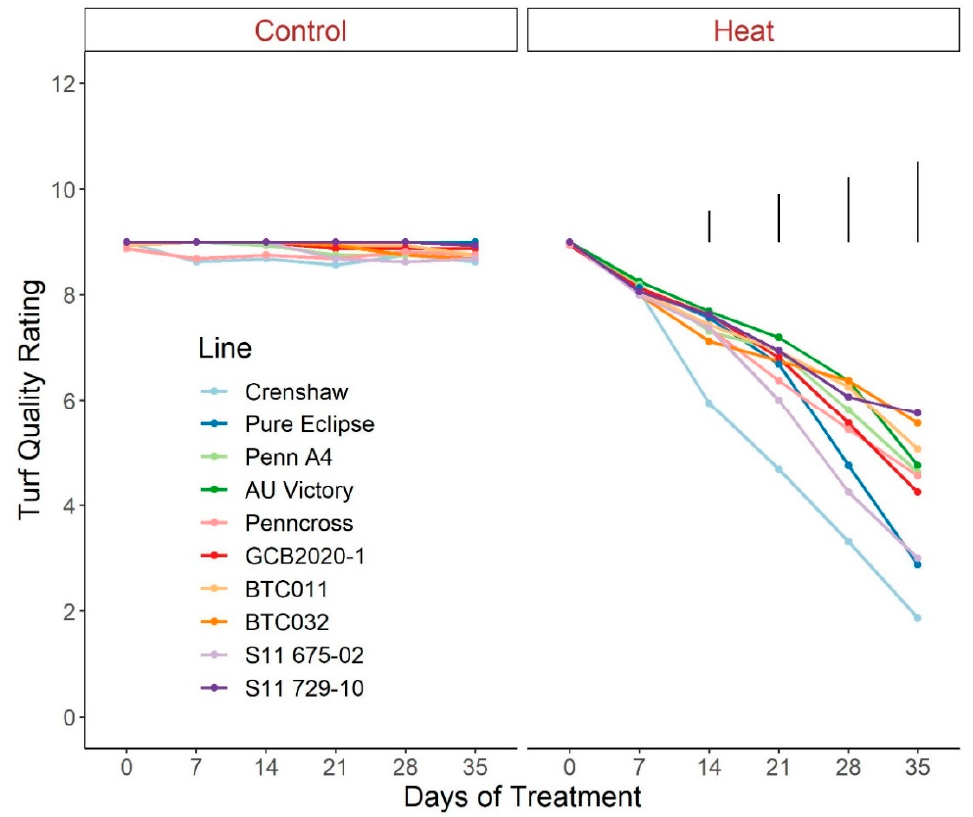
Figure 1. Change in visual turf quality rating for creeping bentgrass lines over time under control (20/15 °C day/night) and heat stress (38/33 °C day/night) conditions. Bars represent LSD values at p = 0.05 on days when significant differences among lines were found.